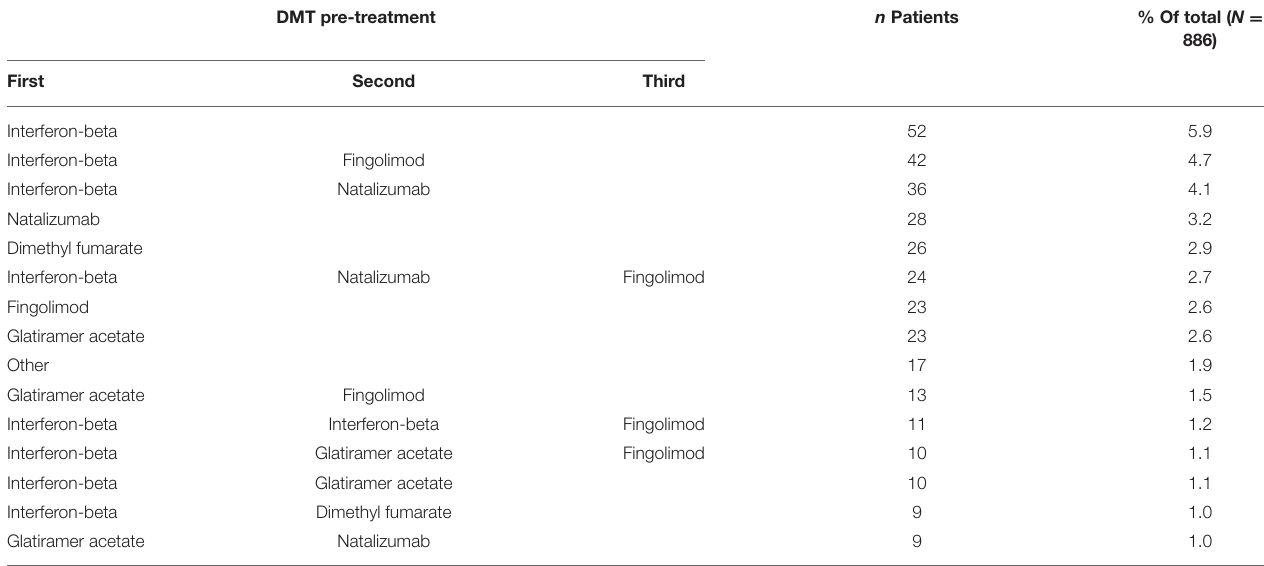
TABLE 3 | Most frequent treatment pathways prior to switch to alemtuzumab. DMT pre-treatment n Patients % Of total ( N =